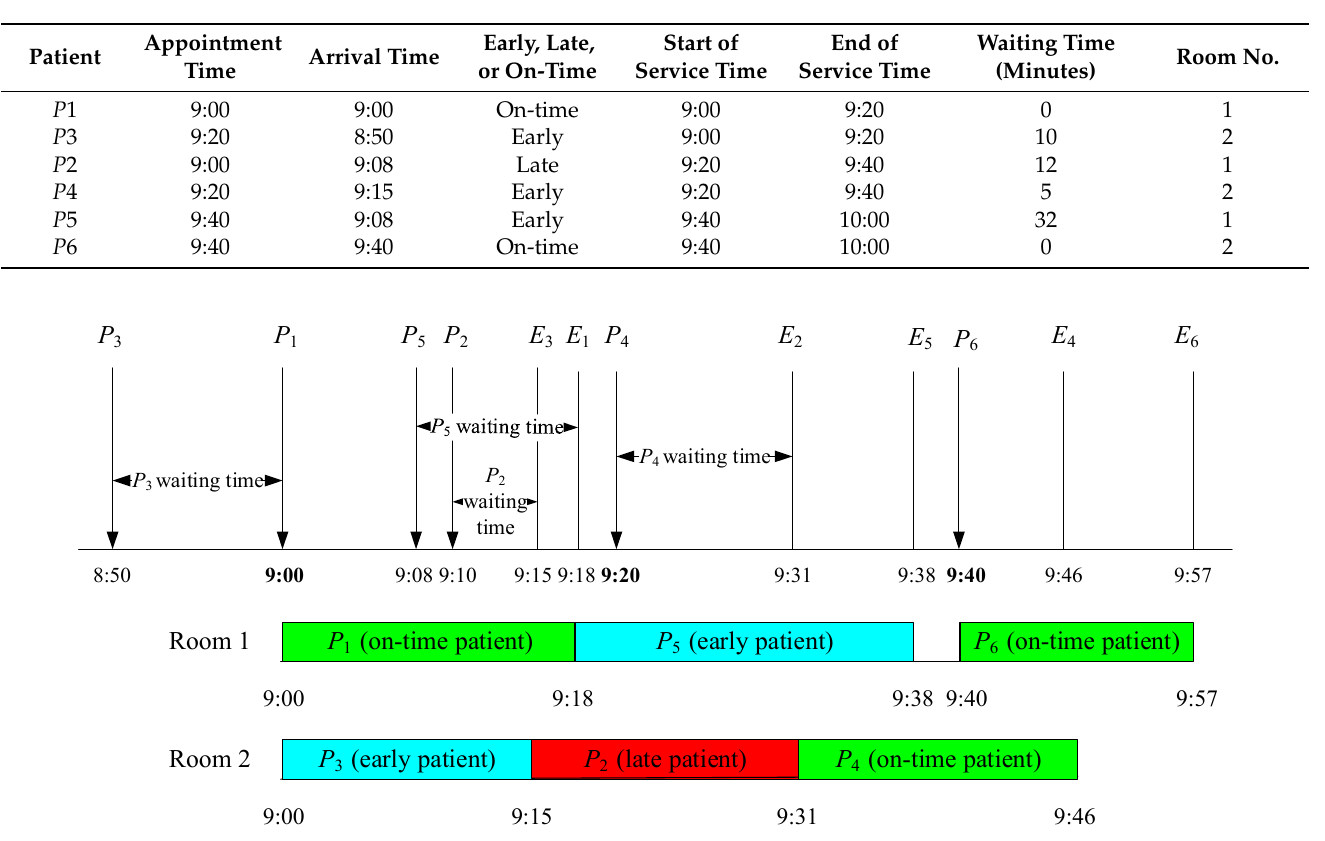
Figure 3. Examples of the preempt policy with variable service time. Table 11. Preempt policy with variable service time.